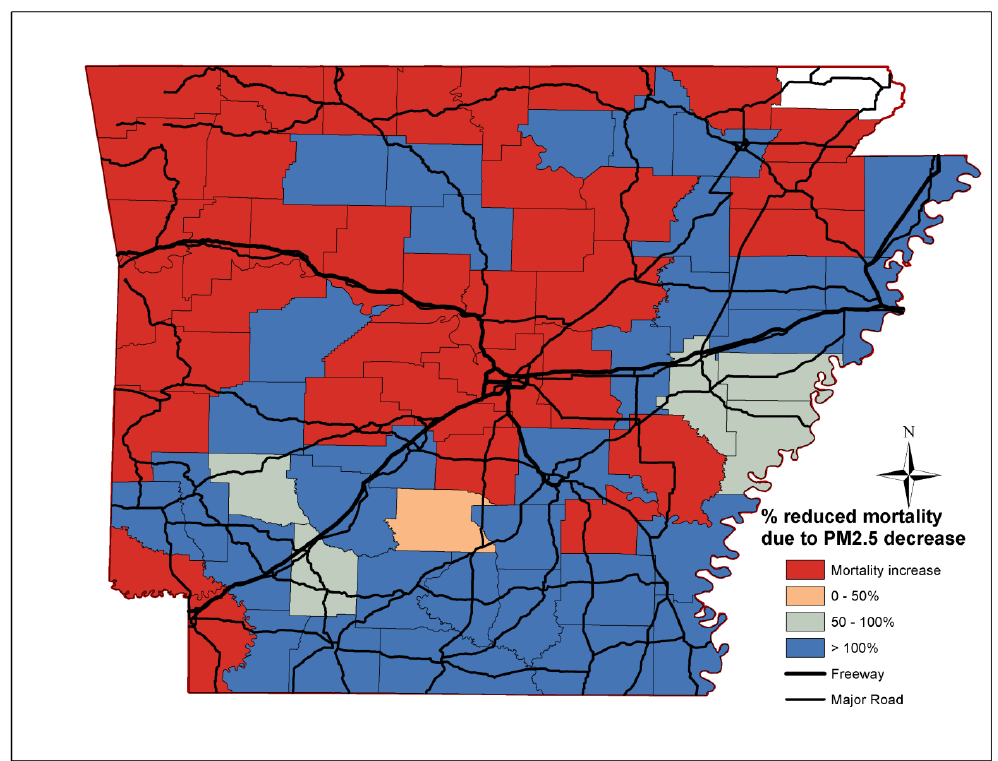
Figure 3. Percentage reduction of non-accidental mortality attributed to PM for each Arkansas county.